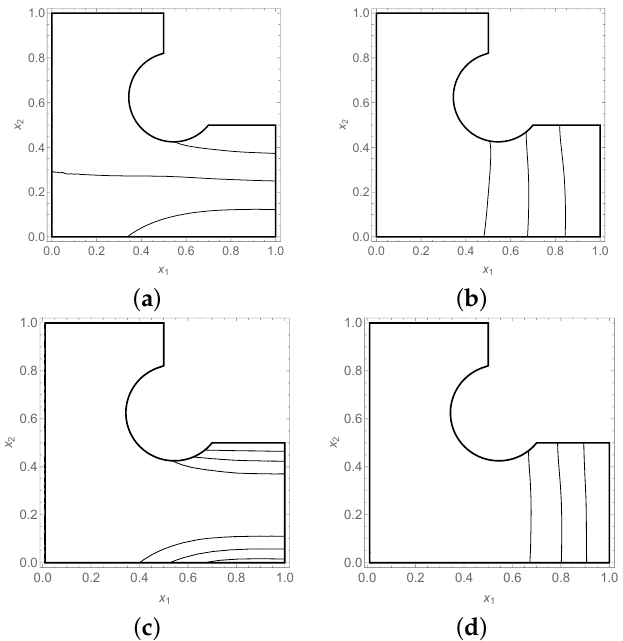
Figure 6. Potential field. Contour plots of the expectation and variance of the solution. ( a ) Expected value of the u 1 -component; ( b ) Expected value of the u 2 -component; ( c ) Variance of the u 1 -component; ( d ) Variance of the u 2